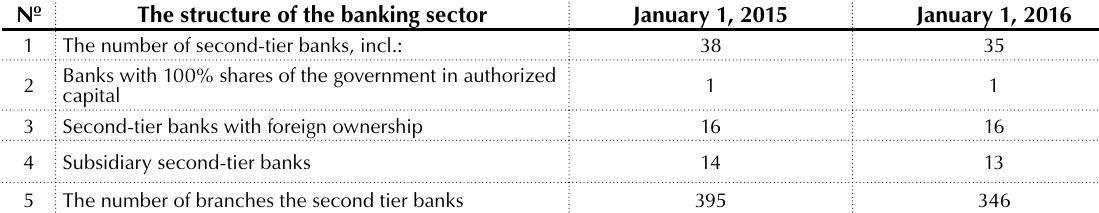
Table 1. The structure of the banking sector of the Republic of Kazakhstan